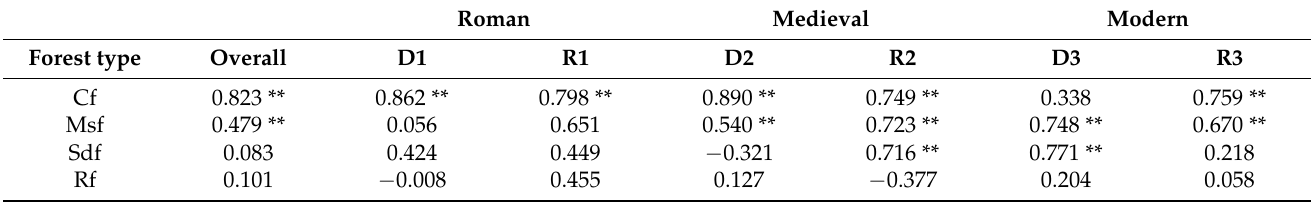
Table 2. Correlations of forest types (Figure 5) with total forest pollen for the total data set (overall) and for each specific deforestation and recovery phase (Figure 4). Forest types: Cf, conifer forest; Msf, Mediterranean sclerophyll forest; Sdf, submontane deciduous forest; Rf, riverine forest. Correlation significance: ** p < 0.01.